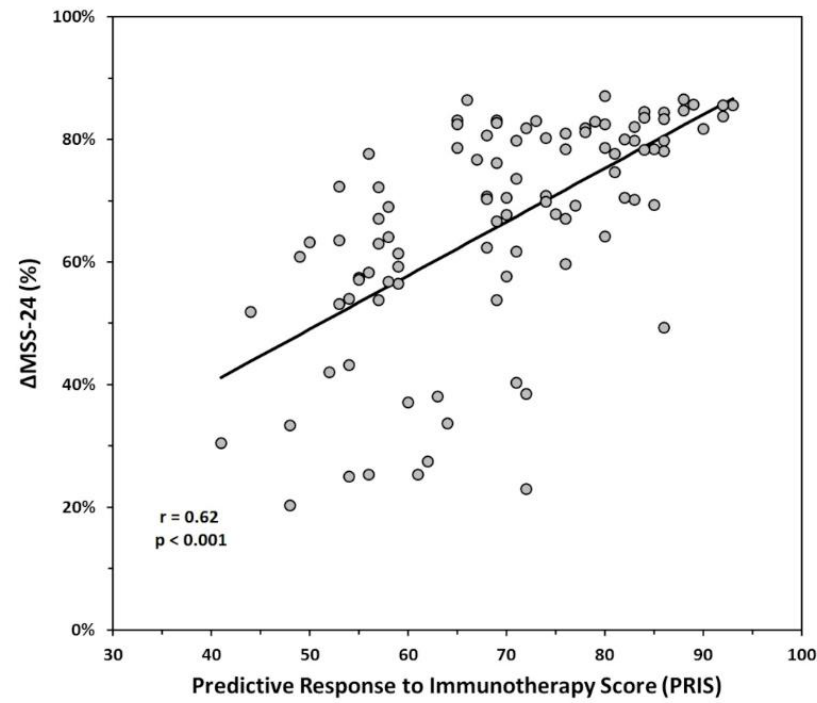
Figure 2. Correlation analysis revealed a significant direct correlation between the Predictive Re- sponse to Immunotherapy Score (PRIS) and ∆ MSS-24 ( p < 0.001). In addition, regression analysis verified that PRIS significantly predicted ∆ MSS-24 (%) in patients treated with a single-allergen SLIT (Mono-SLIT: R = 0.708; F (1.65) = 64.453; p < 0.001; Figure 3A) as well as in patients treated with a two-allergen SLIT (MIX-SLIT: R = 0.599; F (1.31) = 16.833; p < 0.001; Figure 3B), suggesting that PRIS has the same efficacy in predicting SLIT outcome when one or two allergens are used for